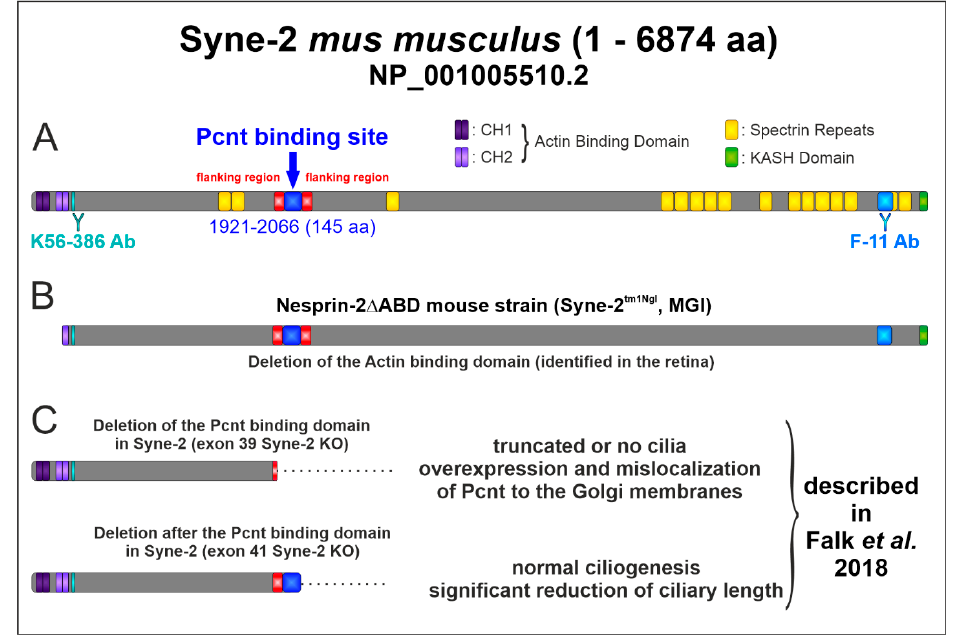
Figure 2. Schematic structure of the Syne-2 protein (NP_001005510.2) and the different deletion forms. ( A ) Structure of Syne-2 containing an N-terminal actin-binding domain composed of two calponin homology domains CH1 and CH2, several spectrin repeats and a C-terminal Klarsicht, ANC-1 and Syne Homology (KASH) domain. The epitopes of anti-Syne-2 antibodies are indicated (K56-386 > N-term domain; F-11 > C-term domain). The localization of the identified Pcnt binding site (exon 39 41, aa residues 1921–2066) is marked in blue [5]. ( B ) Structure of the N-terminal truncated